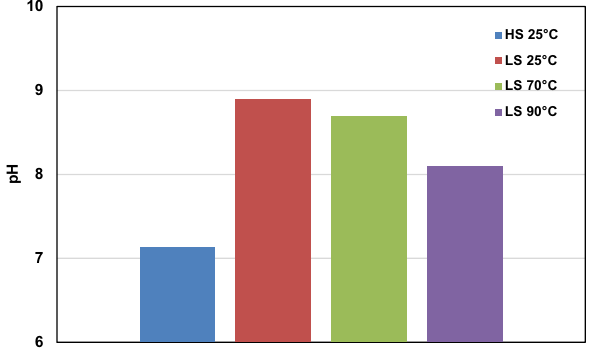
Fig. 4 Oil recovery factor and pressure profile for core#2, which was sequentially flooded by HS water–LS water at 25, 70, and 90 °C